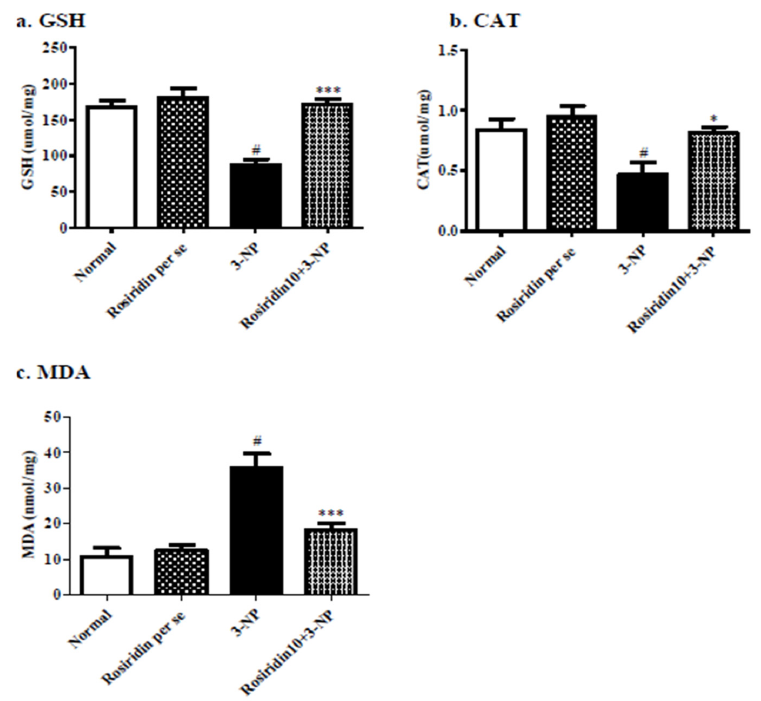
Figure 5. Effect of rosiridin on oxidative stress parameters: ( a ) GSH, ( b ) CAT, and ( c ) MDA. Values are expressed as the mean ± SEM (n = 6). Values are statistically significant at p < 0.05 (one-way ANOVA followed by Dunnett’s test). Express the data ( # p < 0.05) saline vs. negative control group; (*** p < 0.001; * p < 0.05) negative control group vs. treatment group.